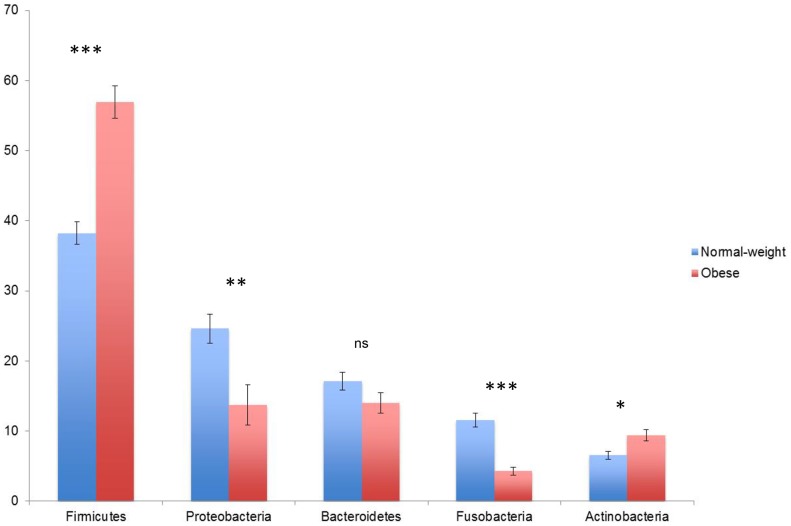
Average abundance of phyla in salivary samples of N and O subjects.Major bacterial phyla in saliva of normal-weight (N) and obese (O) subjects (*P<0.01, **P<0.001, ***P<0.0001, ns: not significant). Bars indicate standard error.